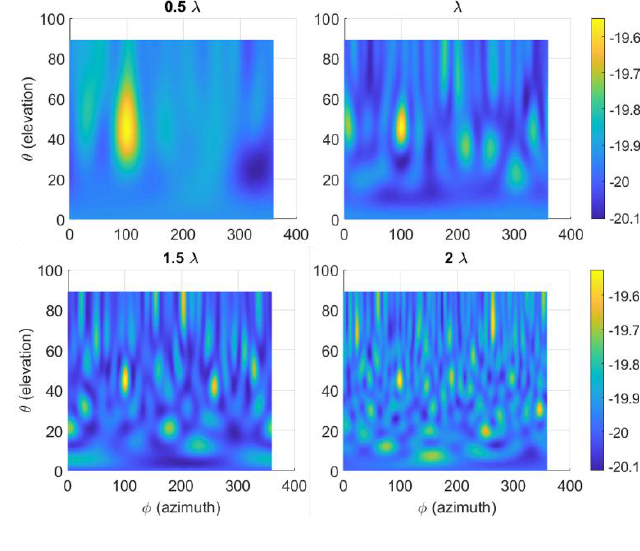
Fig. 6. Results of UCA Beamforming